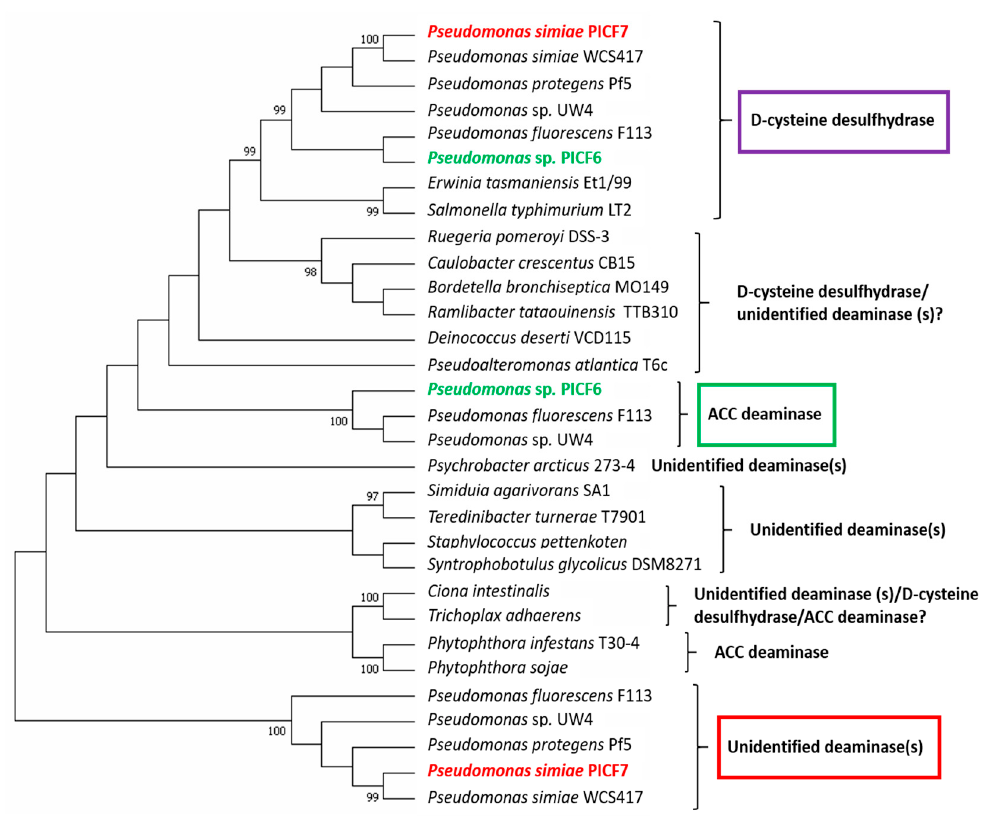
Figure 4. Dendrogram based on the comparison among 1 ‐ aminocyclopropane ‐ 1 ‐ carboxylic acid (ACC) deaminase, D ‐ cysteine desulfhydrase and other unidentified deaminases coding genes from different (micro)organisms. Pseudomonas sp. PICF6 (green text) harbors a true ACD (green rectangle). Pseudomonas simiae PICF7 (red text) harbors an unidentified deaminase (red rectangle) and a D ‐ cysteine desulfhydrase (purple rectangle), but does not harbor a true ACD. A D ‐ cysteine desulfhydrases was also found in strain PICF6. The tree was inferred by using the Maximum Likelihood method. Only bootstrap values ≥ 95% based on 1000 re ‐ sampled datasets are displayed in the phylogram branches.